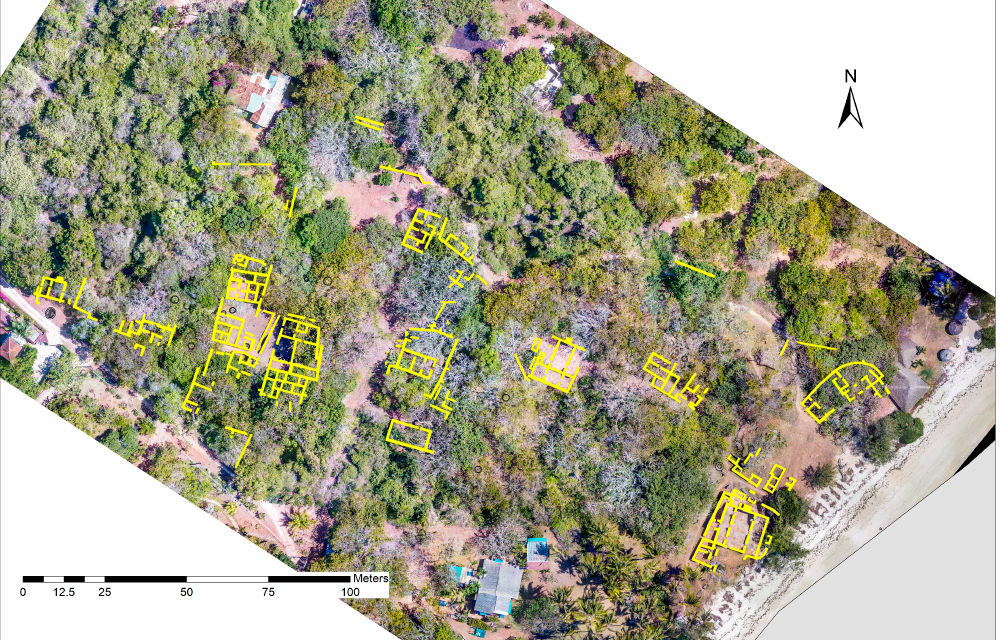
Figure 2. The aerial view of Jumba la Mtwana showing the location of buildings and isolated standing walls in yellow.